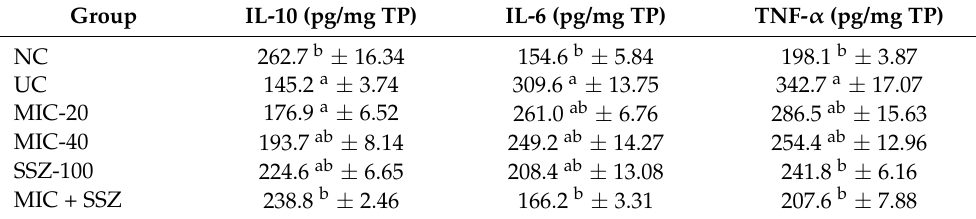
Table 5. Effect of miconazole, sulfasalazine and their combination on the anti-inflammatory cytokine IL-10 and pro-inflammatory cytokines IL-6 and TNF- α in AA-induced UC. Group IL-10 (pg/mg TP)